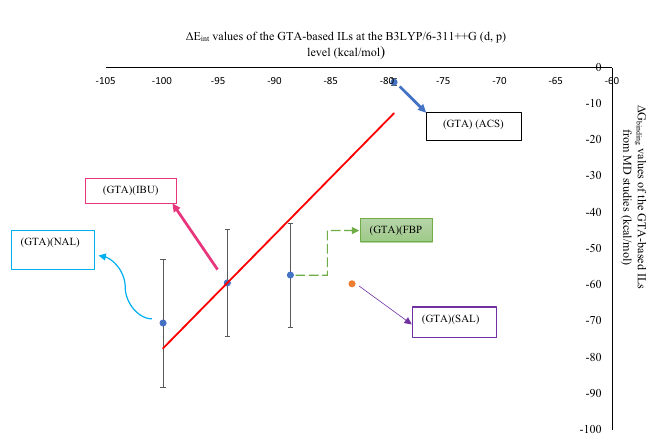
Figure 7. Correlation between ΔG binding (kcal mol −1 ) from 20 ns of MD simulation and ΔE int (kcal mol −1 ) from QM studies in: (GTA) (ACS), (GTA) (FBP), (GTA) (IBU), and (GTA)(NAL), (error bar % = 25).